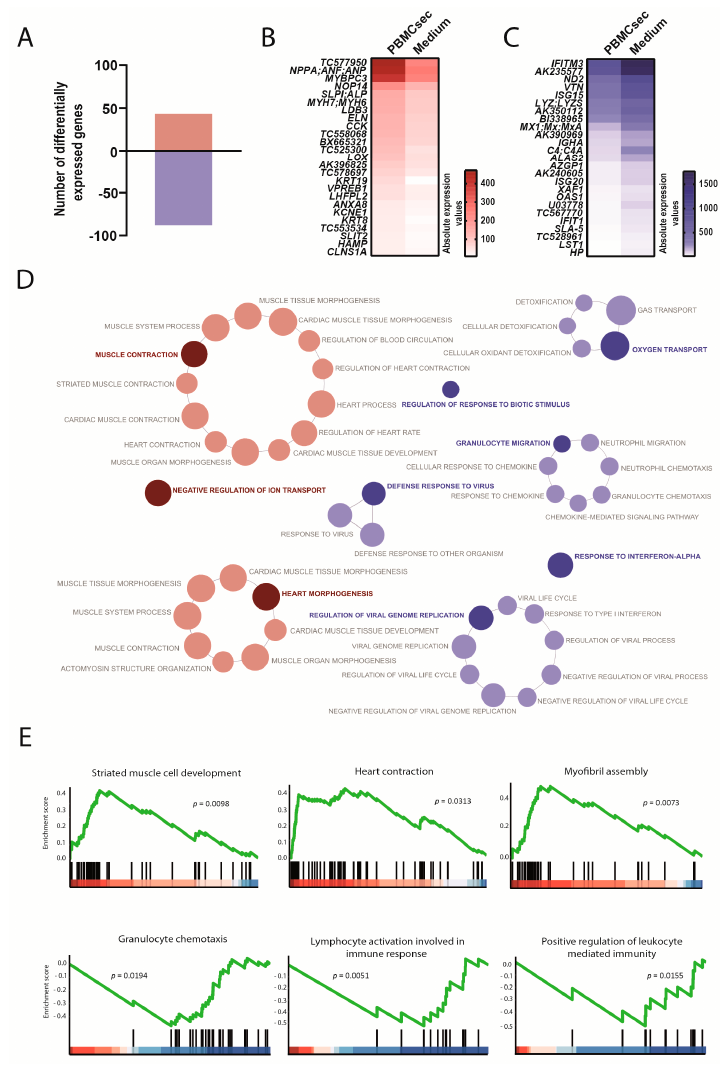
Figure 3. Transcriptional changes induced by the PBMCsec in the infarcted area. ( A ) Total numbers of differentially expressed genes. Red and blue indicate up- and downregulated genes, respectively, when comparing the PBMCsec versus the medium. The average fold change of n = 6 animals per group is shown. Absolute expression values of genes ( B ) up- and ( C ) downregulated by the PBMCsec compared with the medium. Colors indicate expression values. ( D ) GO terms associated with up- (red) and downregulated (blue) genes. Each circle represents one term. Circle sizes indicate p -values. Overarching terms within a group are highlighted in bold. ( E ) GSEA of up- (upper panel) and downregulated (lower panel) genes by the